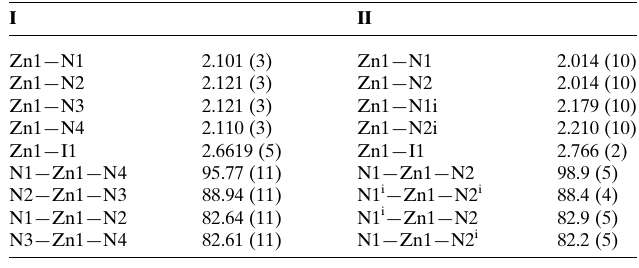
Table 1 Selected geometrical parameters (A˚ , (cid:5) ) of the complex cations.